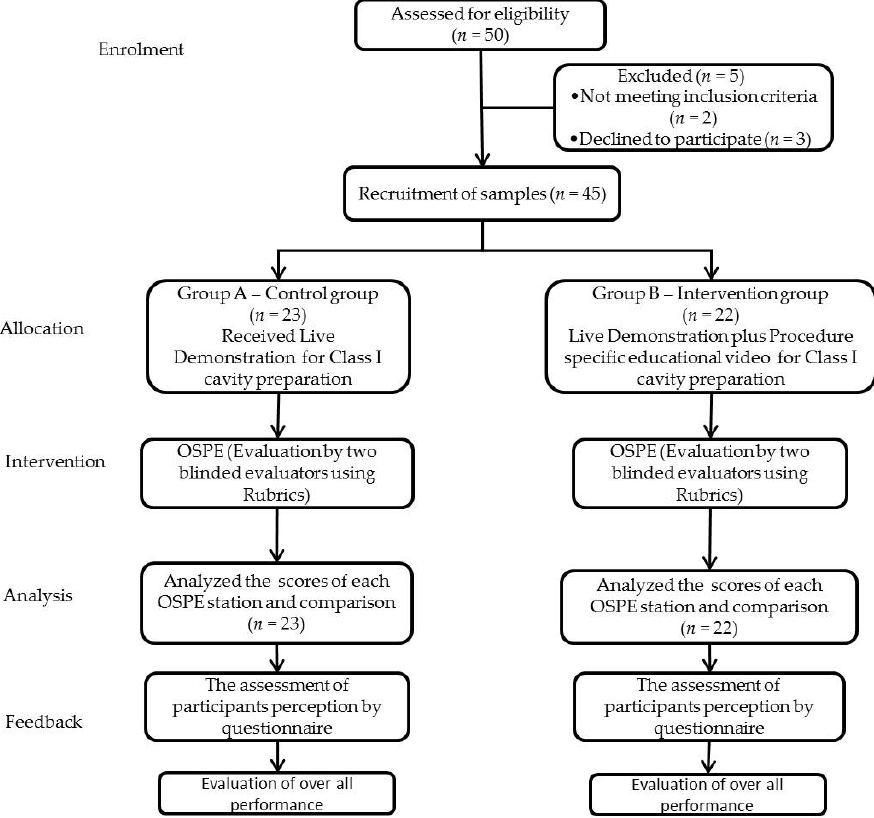
Figure 1. Summary of research methodology and experimental protocol.